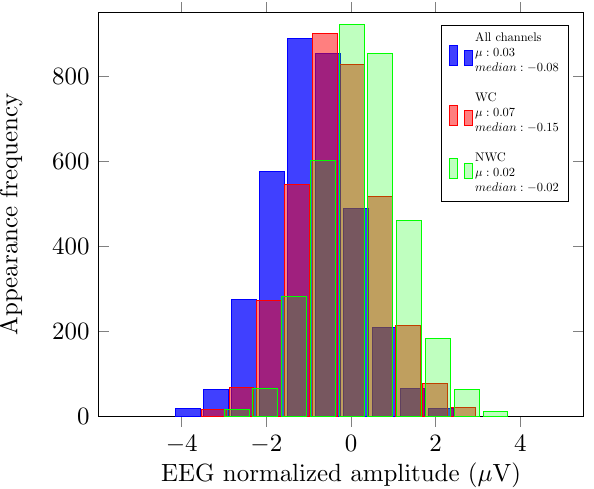
Figure 2. Histograms of User 1 pre-recording.